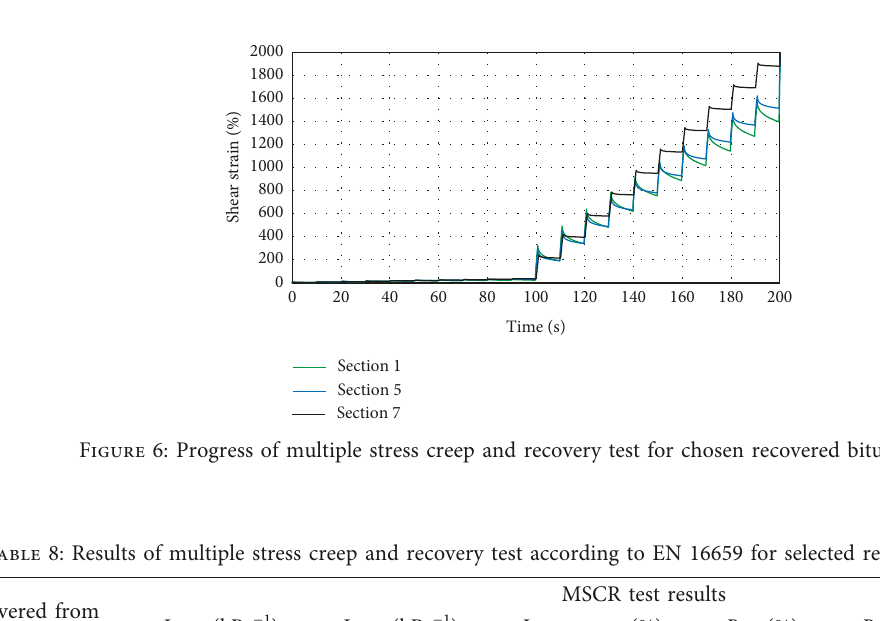
MSCR test results